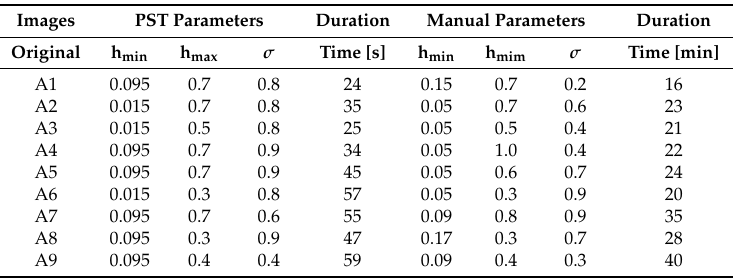
Figure 6. Optimal Canny segmentation; ( A ) Original images; ( B ) PST results; ( C ) Manual results obtained by an expert.